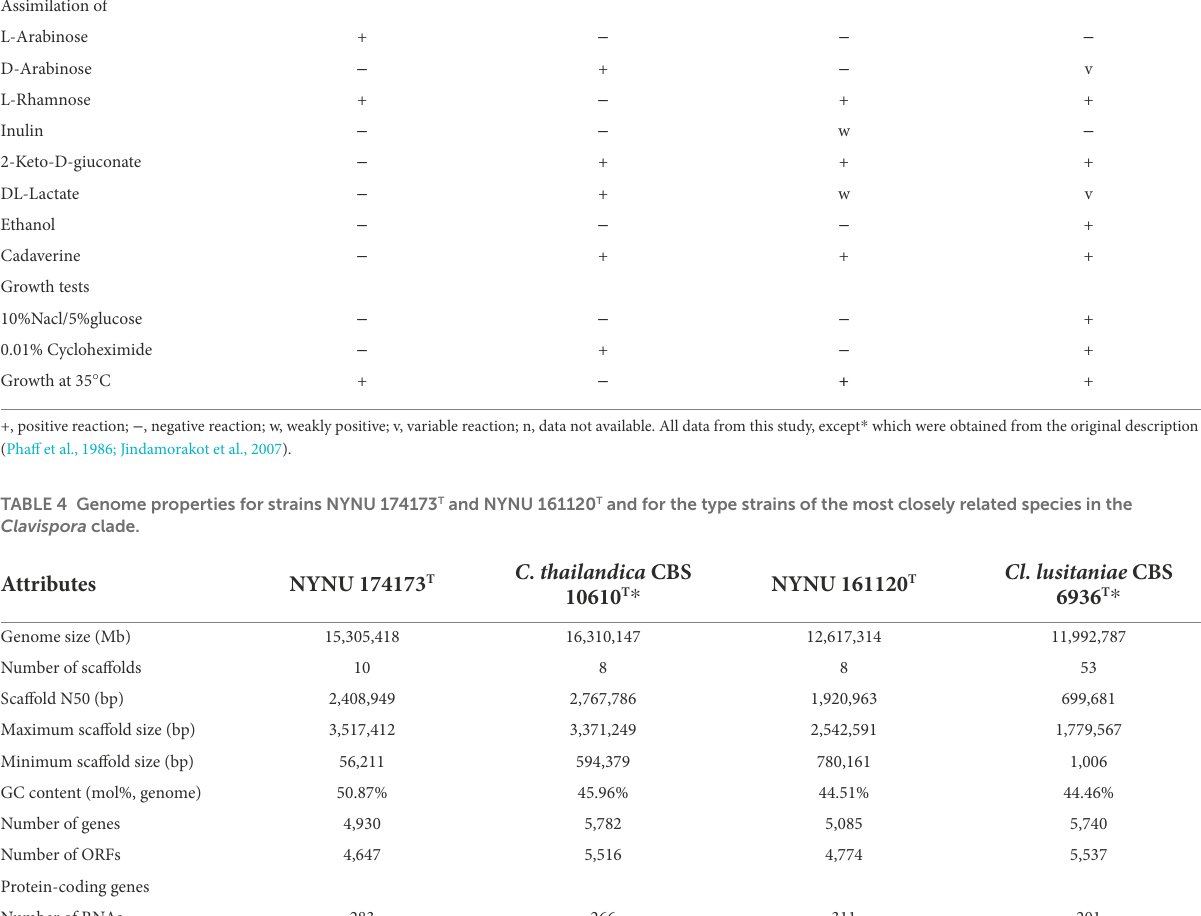
(Table 5); the ANI and DDH values between the strain NYNU 161120 T and Cl. lusitaniae CBS 6936 T were 94.72 and 53.50%, respectively. All these percentages were lower than 95 and 70%, respectively, which are the defined cut-off limits for species delineation (Lachance and Lee, 2020; Cadež et al., 2021), and further support the inclusion of these two strains as novel taxa in the Clavispora clade.